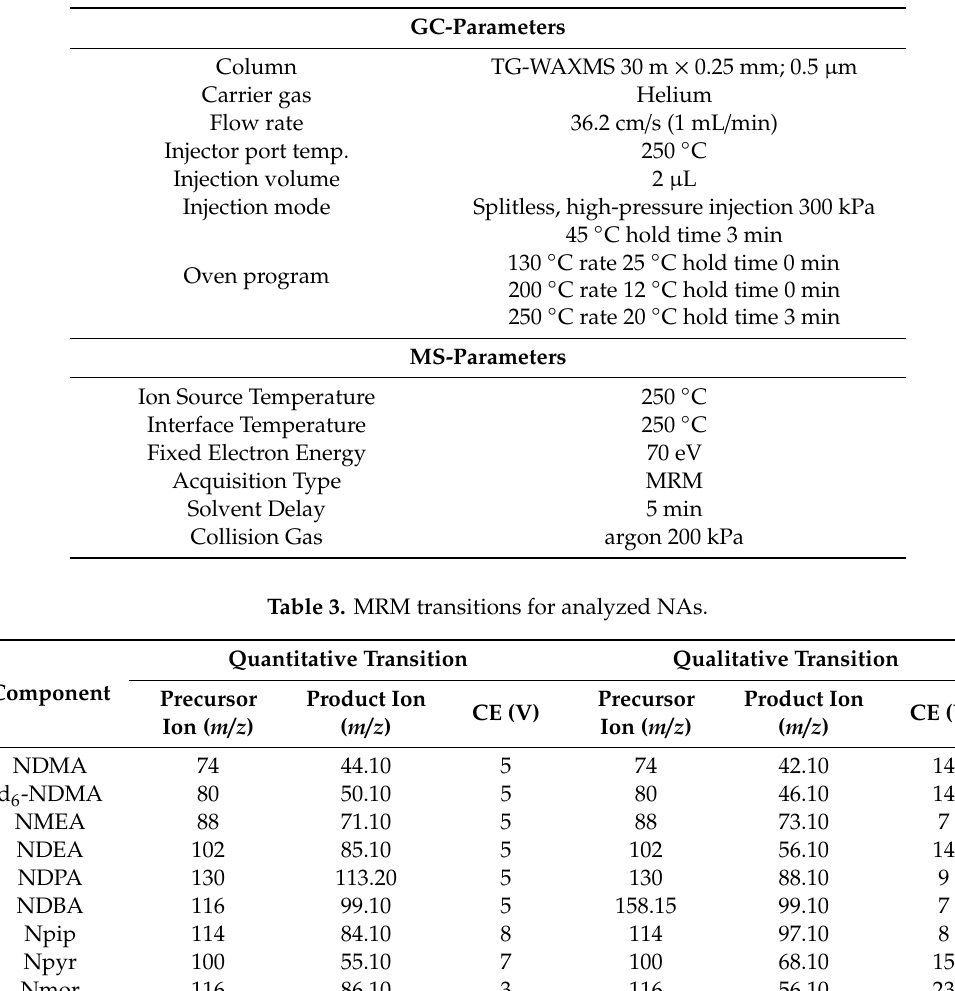
Table 2. Parameters of the developed GC-MS method.